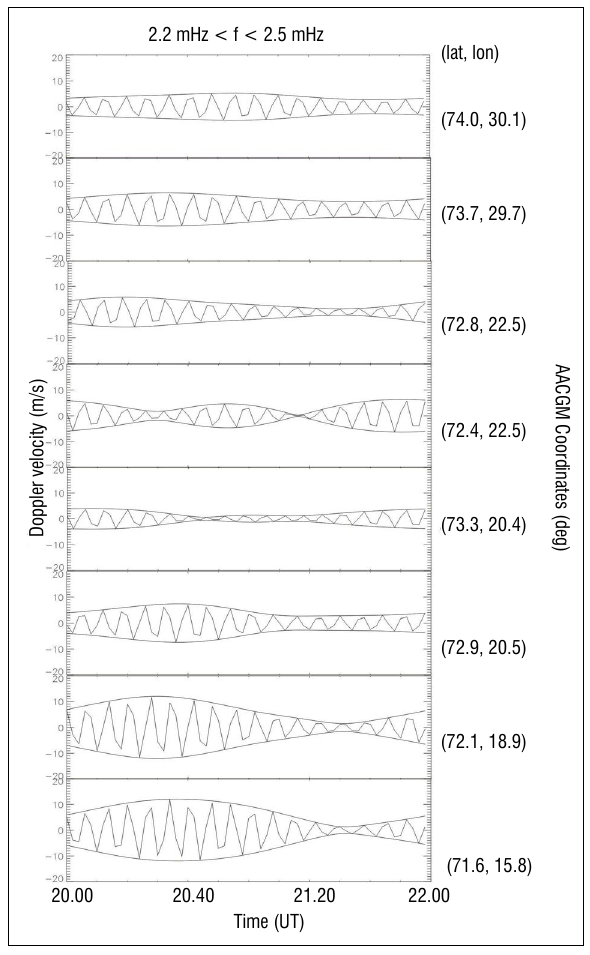
Figure 9: Stackplot of the analytic signal amplitude envelopes for various beams of the Goose Bay radar at the mentioned range gates.